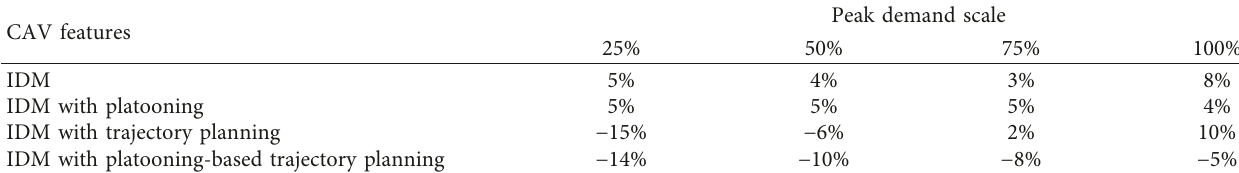
Table 6: Average fuel consumption improvement magnitudes of superstreet compared to the equivalent conventional intersection with different CAV